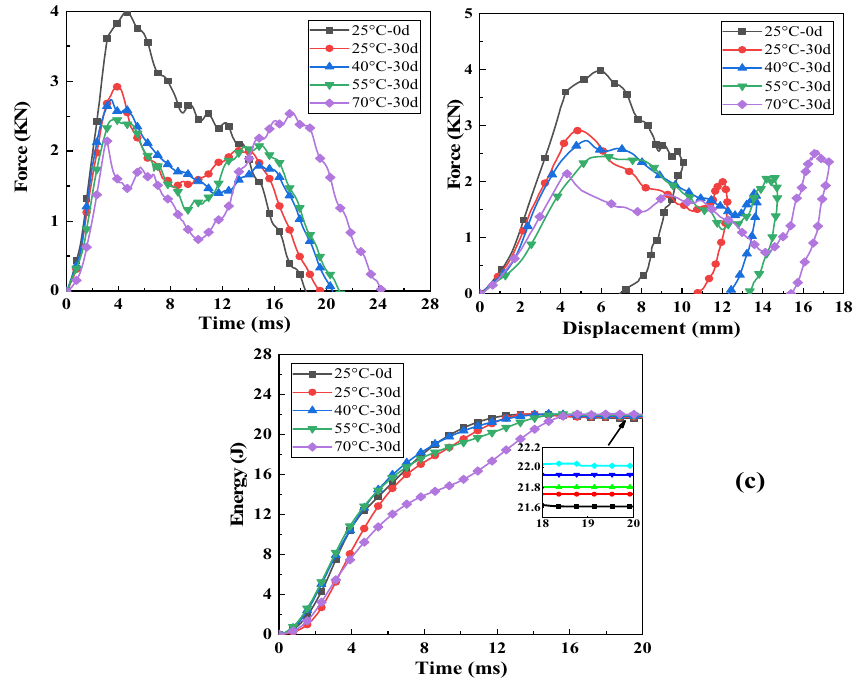
Figure 7: Typical impact responses ( force – time, force – displacement, and energy – time ) of the sandwich panels for the three impact energies: ( a ) 10 J, ( b ) 16 J, and ( c ) 22 J.